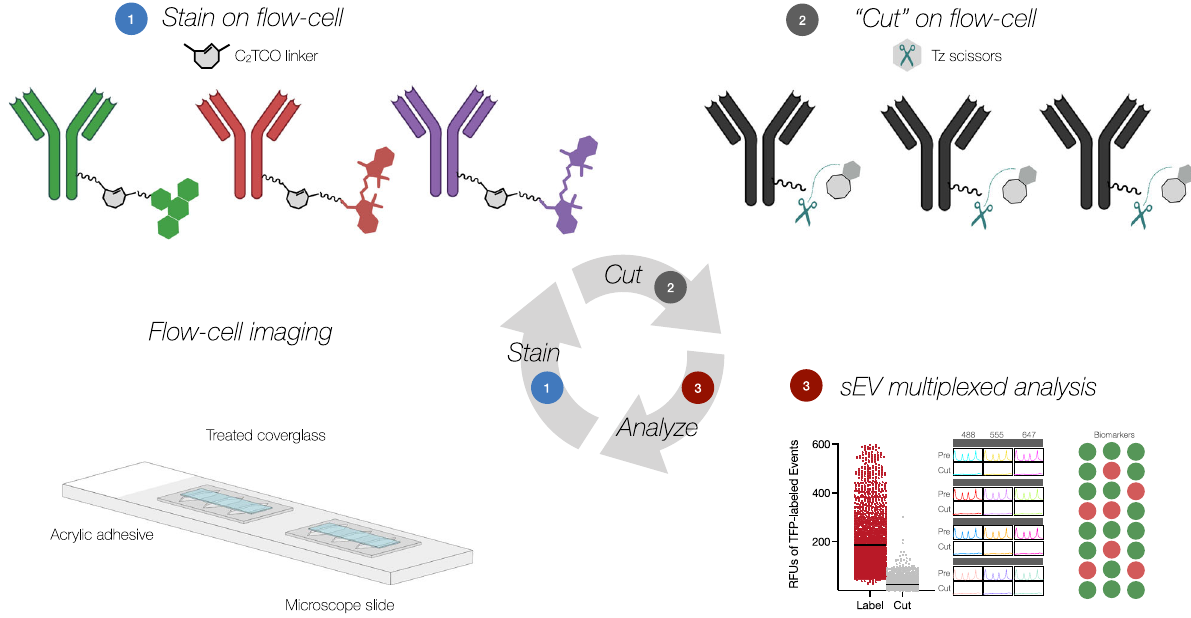
Fig.1|OverviewofiterativemultiplexedanalysisofsingleEV(MASEV).1 Usinga fl ow cell, pre-puri fi ed EV (labeled with unquenchable TFP-AF350) are attached